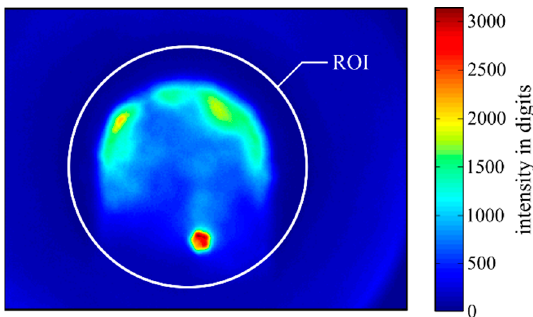
Figure 4. Example image in false colours, taken during the variation of laser power at P = 1800 W. It shows the intensity distribution of the melt pool. To cut away the misdirected melt pool radiance (light blue), a region of interest (ROI) was adjusted and set to the position of the nozzle opening.